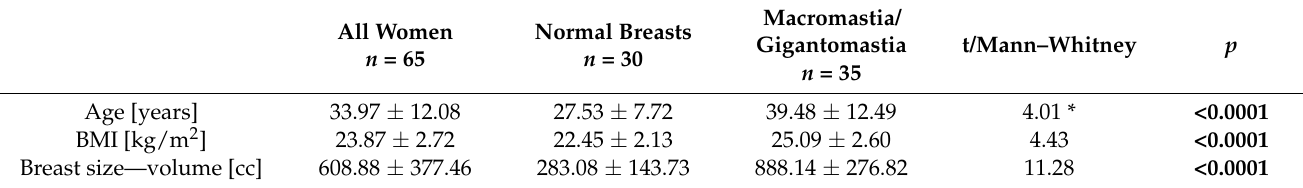
Table 1. Characteristics of the examined